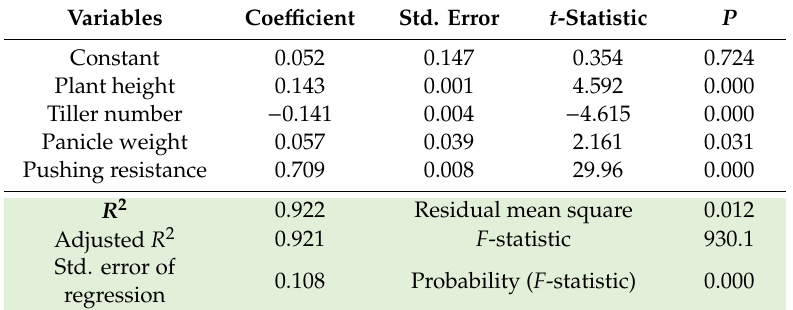
Table 4. Multiple linear regression results with base failure moment as the dependent variable.